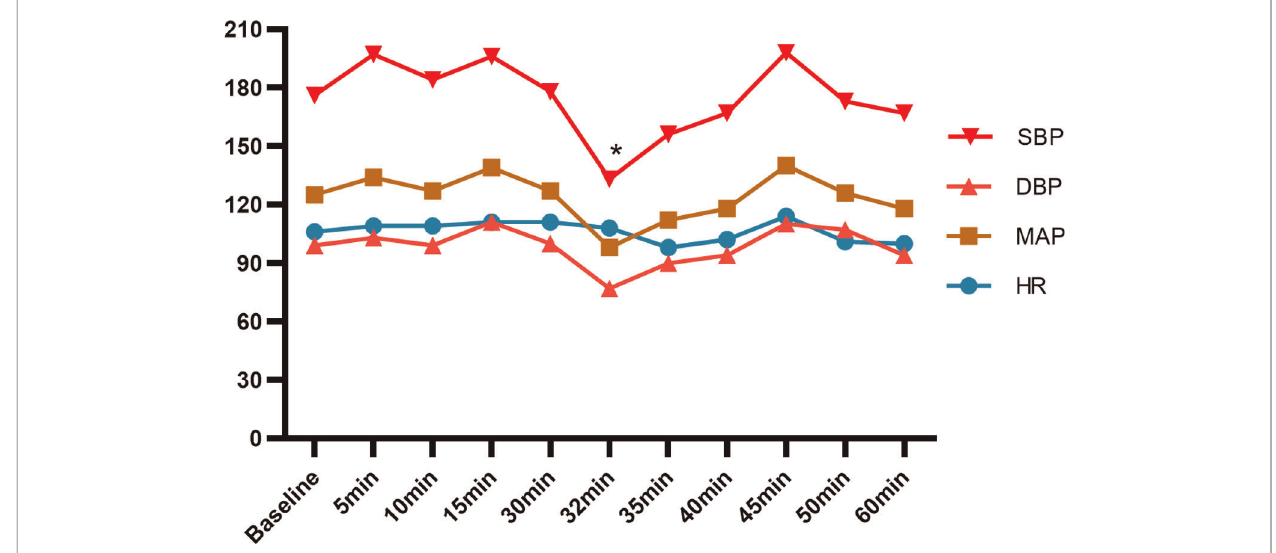
FIGURE 2 | BP and HR of case 2 after epidural anesthesia. SBP, systolic blood pressure; DBP, diastolic blood pressure; MAP, mean artery pressure; HR, hearte rate. *intravenous injection of 50 µg